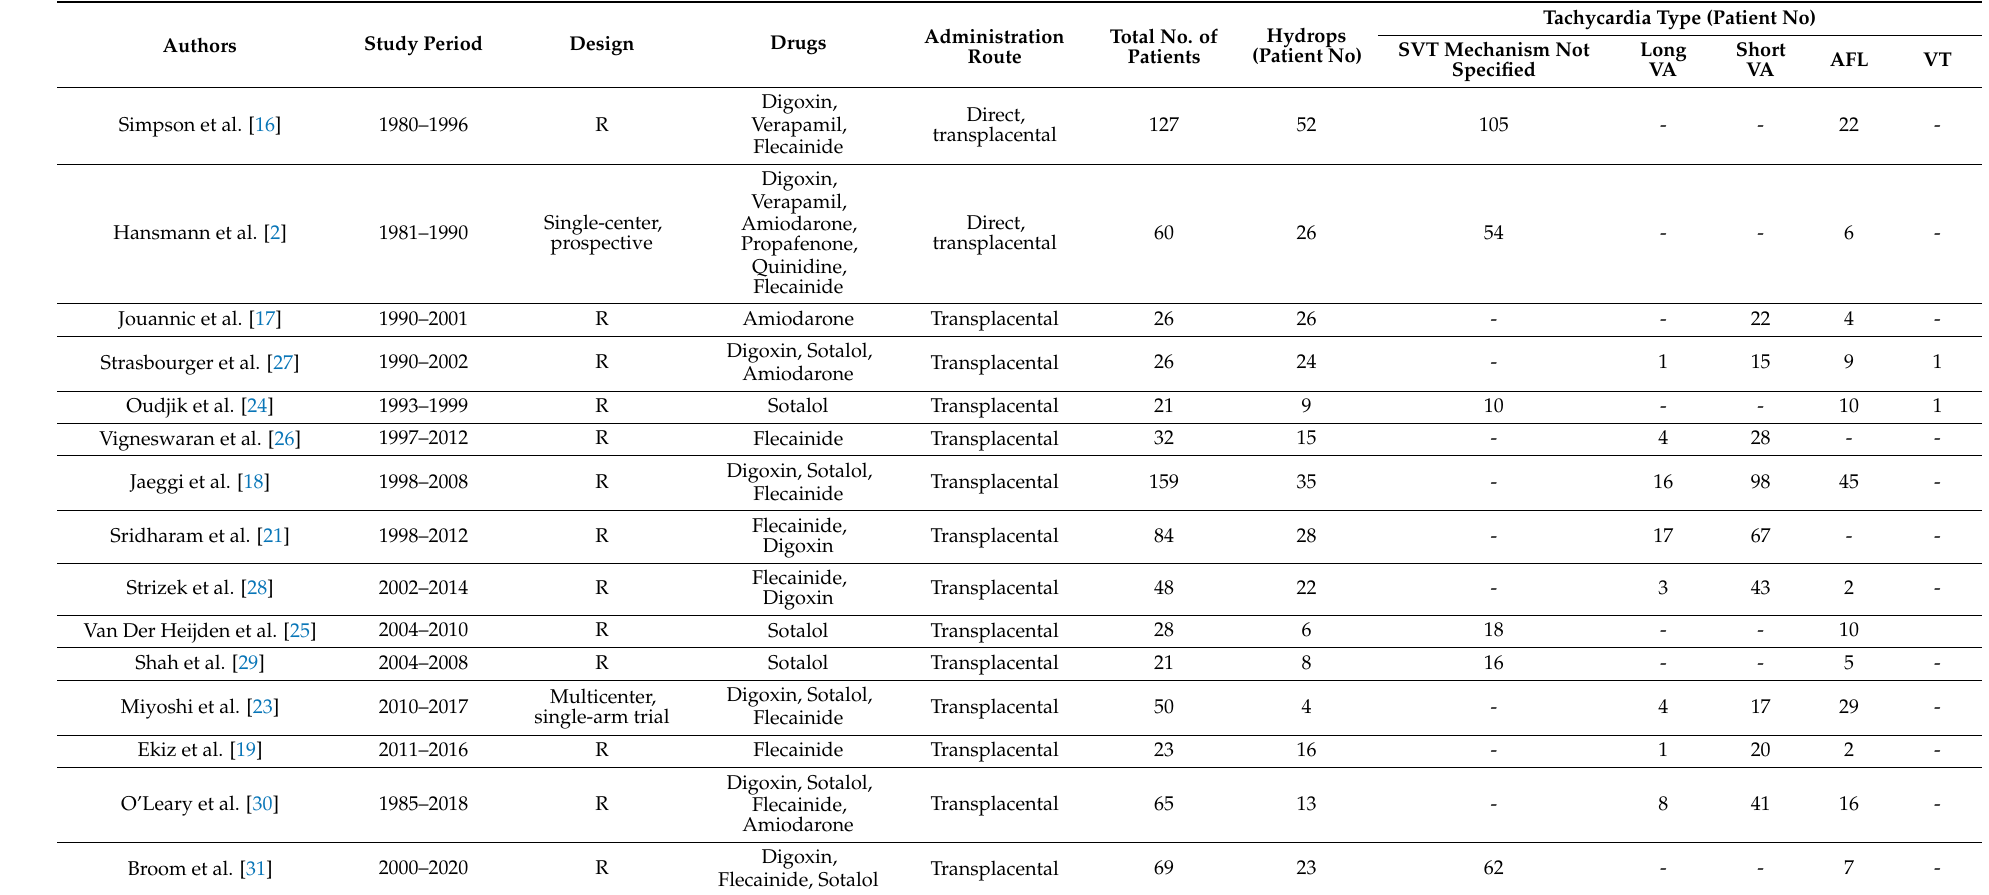
Table 2. Summary of study protocols found in the